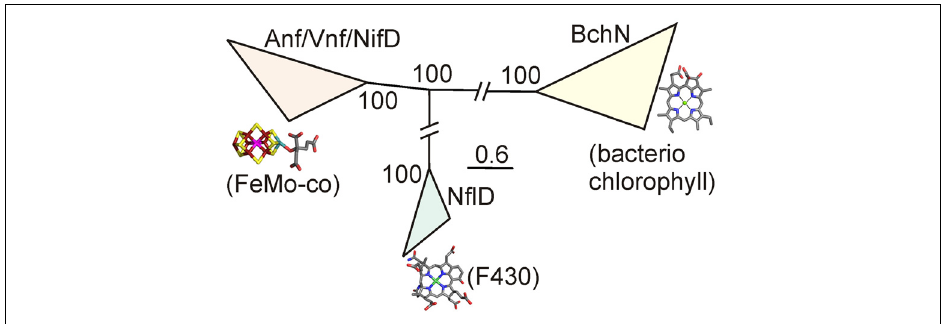
FIGURE 4 | Phylogenetic relationships between Anf/Vnf/NifD, Bch/ChlN, and NflD proteins, as reproduced from Boyd et al. (2011b). Parsimony would suggest that the ancestor of this paralogous group of proteins likely harbored an open active site cavity similar to that which is present in modern NflD or Chl/BchN proteins. The ancestor of these protein complexes (at the trifurcation point of the tree) likely encoded a single structural protein approximating NflD. A series of ancient duplications followed by independent evolution yielded the precursor to the heterotetrameric BchNB and NifDK complex (See Figure 3 for a schematic outlining this evolutionary